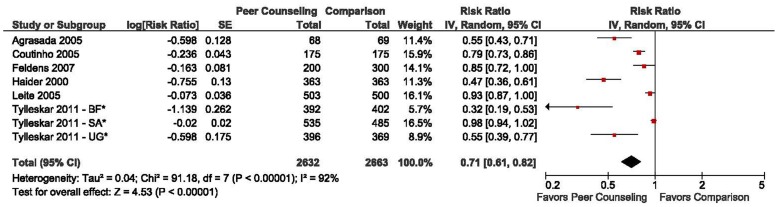
Pooled relative risk and 95% confidence intervals for the effect of peer support on discontinuing EBF.*Results from multicenter Tylleskär trial reported seperately. BF: Burkina Faso, SA: South Africa, UG: Uganda.